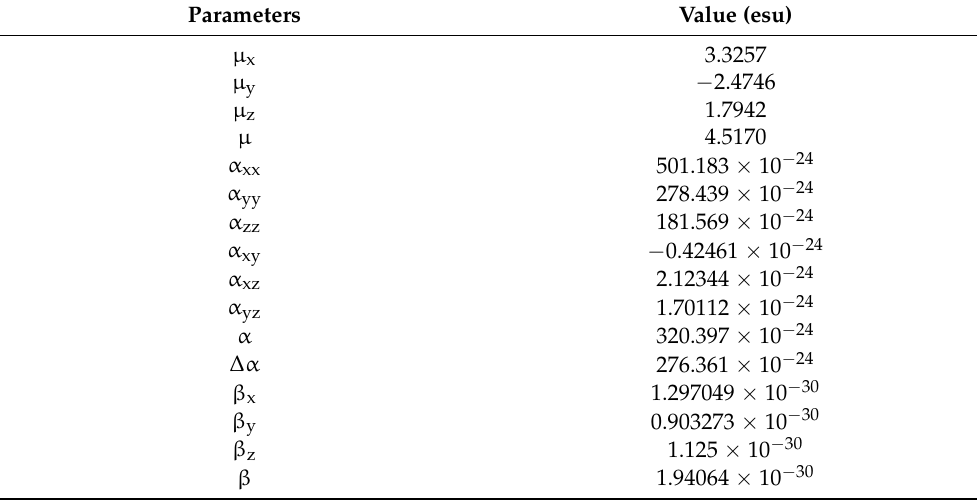
Table 8. The NLO parameters of HMD.